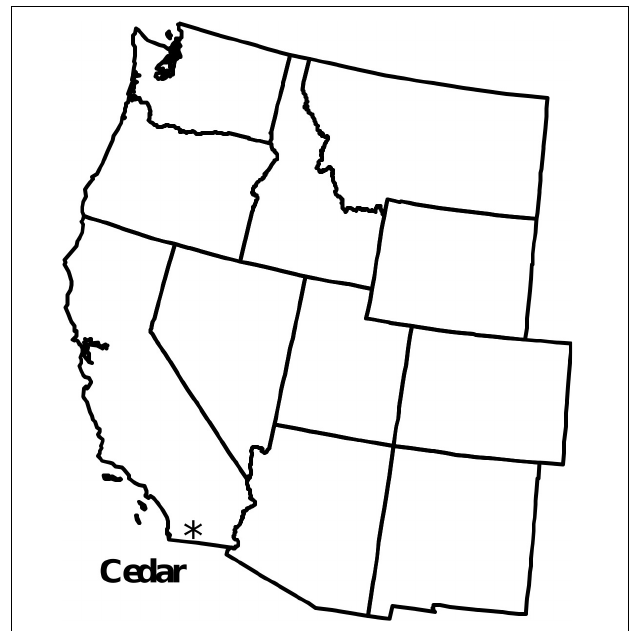
FIGURE 1 | Map of Cedar Fire study location near Alpine, California.